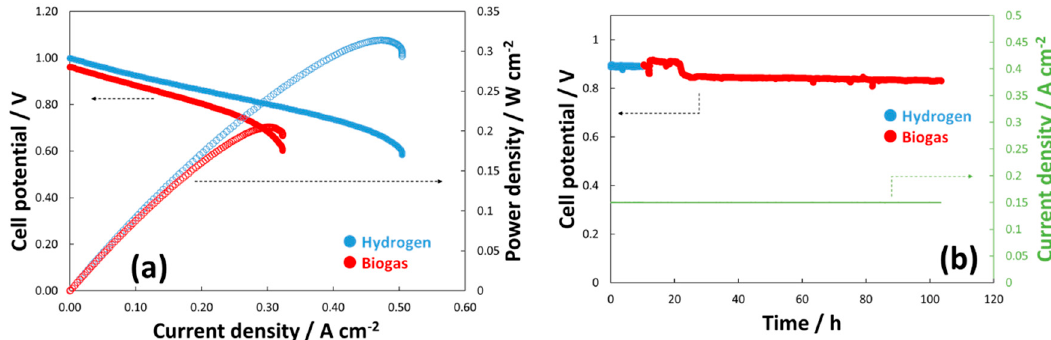
Figure 6. Polarization curves ( a ) and lifetime test ( b ) carried out with a novel NiCu-exsolved La 0.6 Sr 0.4 Fe 0.8 Co 0.2 O 3 (LSFC) perovskite composite catalyst. These tests have been carried out at 650 °C with NiCu-LSFC coated on an Elcogen cell fed with H 2 and biogas (30 vol.% of CO 2 ). (Standard deviation was < 5 mV for each data point of the overall polarization dataset).